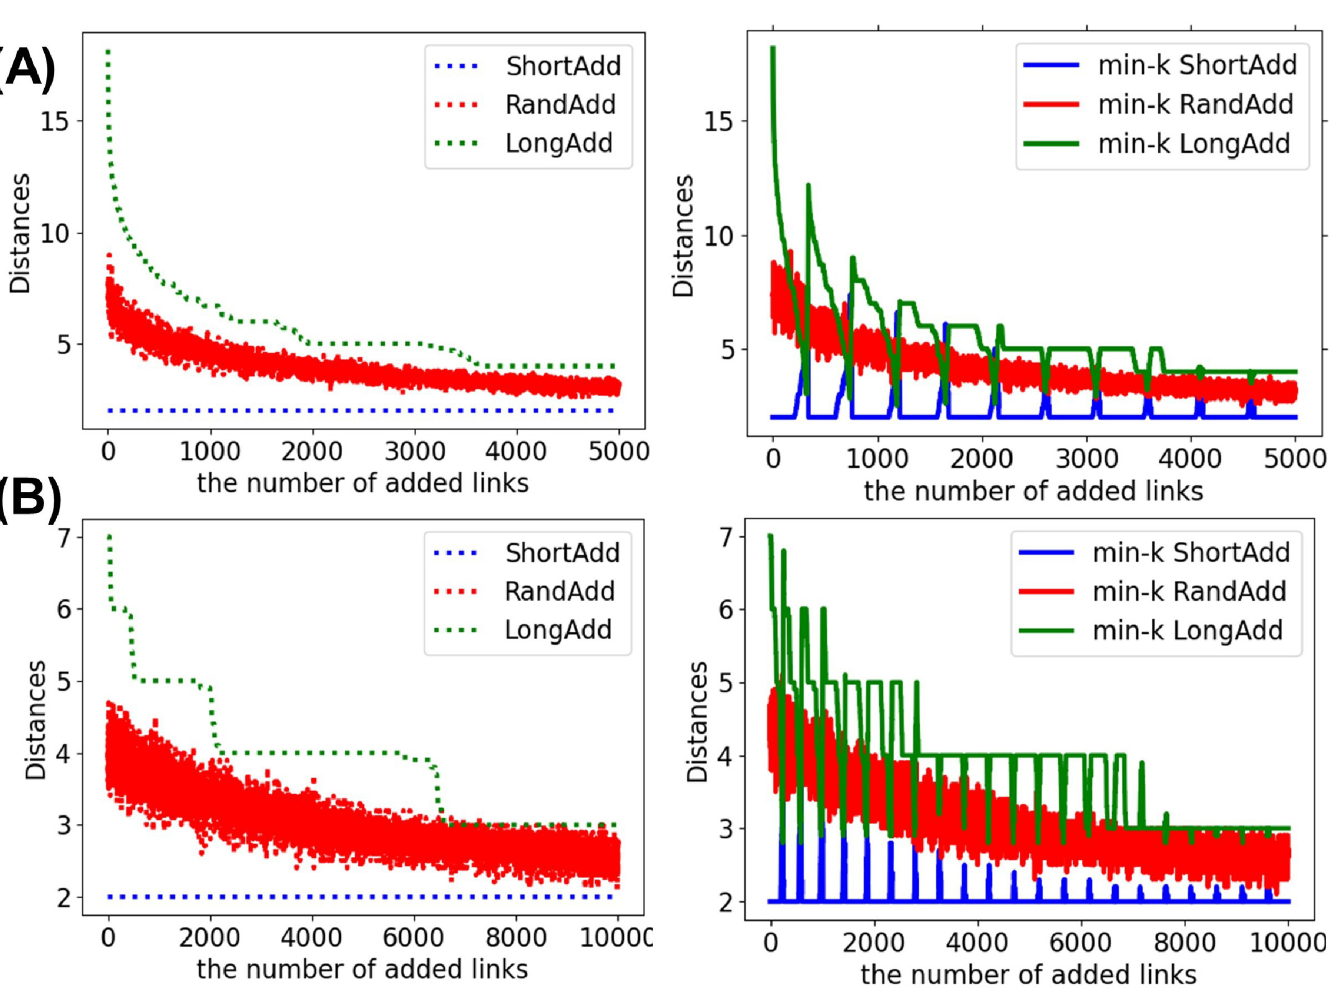
Fig 8. Distance between selected node pairs for adding links to SF networks. The LongAdd method (green dotted lines) selects node pairs with the longer distances, while the ShortAdd method (blue dotted lines) selects node pairs with the shorter distances. The LongAdd method (green dotted lines) selects node pairs with longer than the min- k LongAdd methods (green solid lines). The initial networks are SF networks with N = 1000 and (A) h k i = 2 or (B)